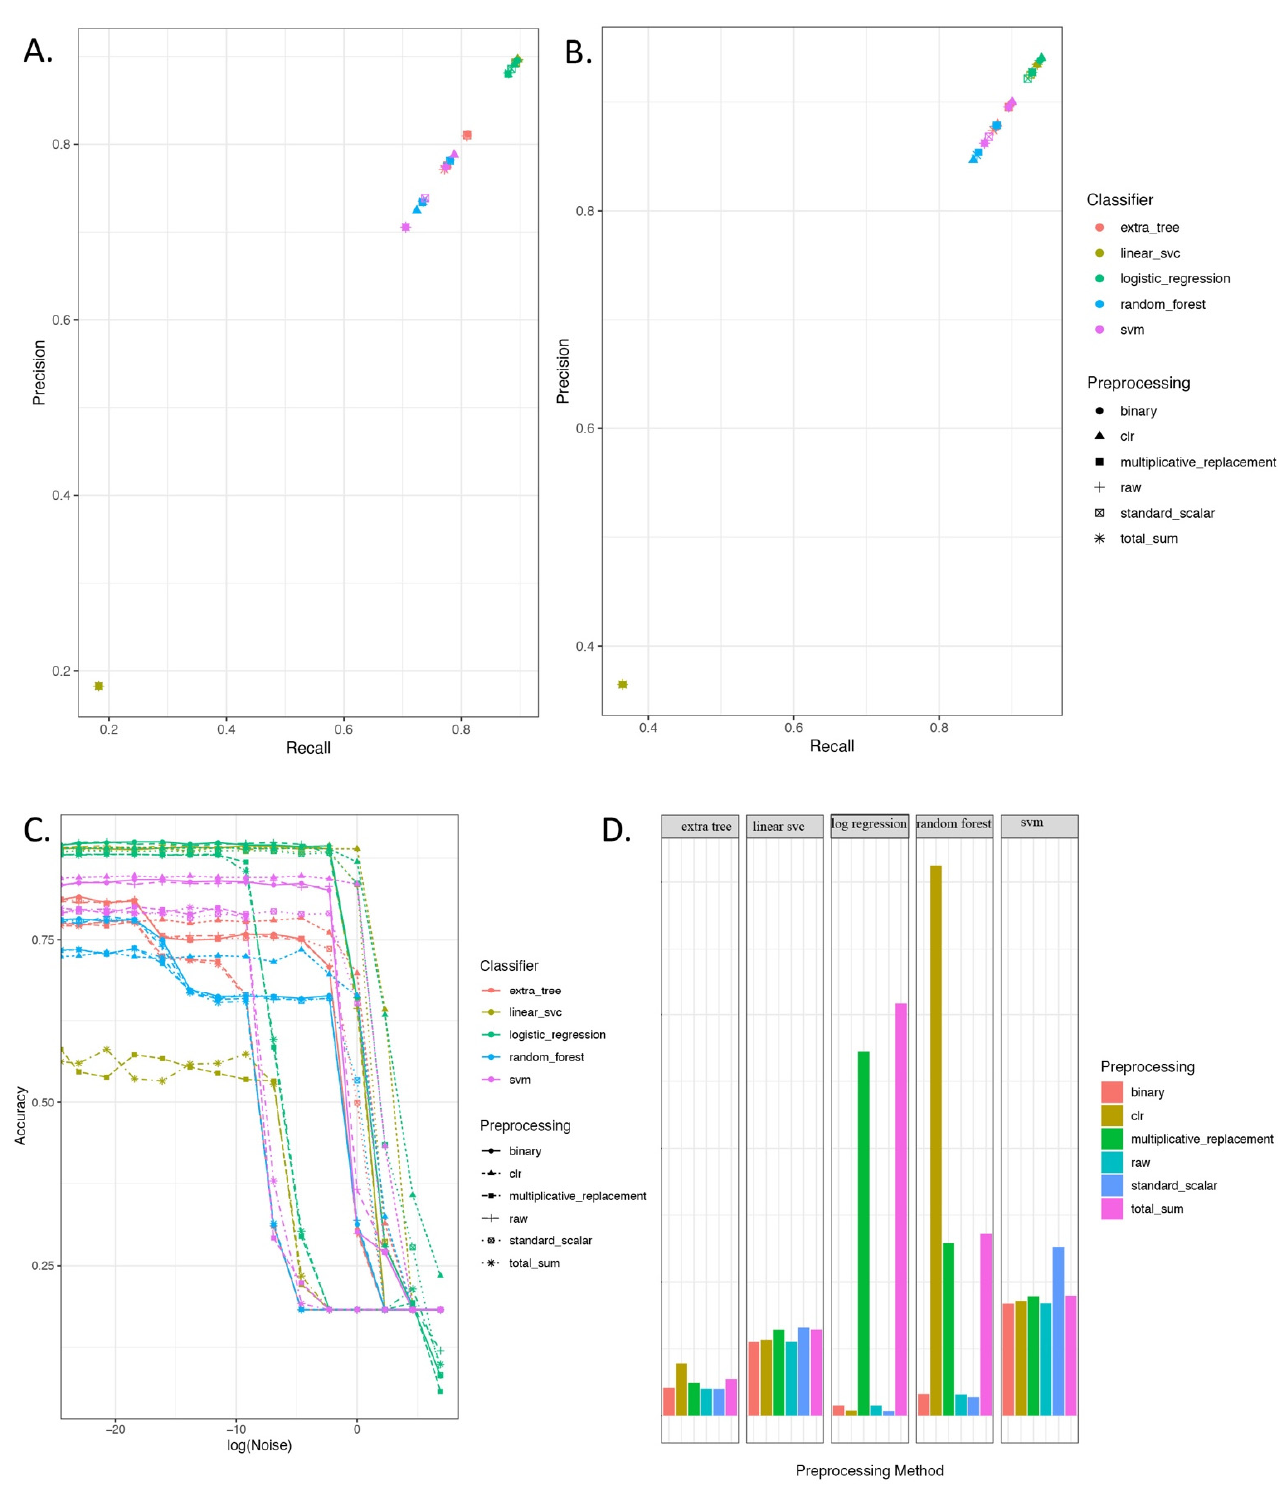
Figure 2. Performance of the ML tools for predicting geolocation from MetaSUB dataset. Top 5 methods to detect microbial fingerprints of cities with high precision and recall for ( A ) city. ( B ) continents. Micro-averaging (used for un-balanced classes in NumPy) has been used for calculating the precision and recall values to account for class imbalances. ( C ) Gaussian noise (used to mimic metagenomic noises) for the best preprocessing method for each model to predict city ( D ) Training time required for city classification.